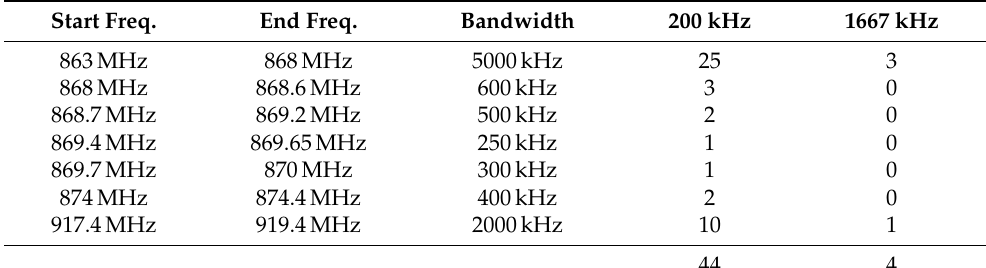
Table 2. Possible channel allocations for 200kHz and 1000kHz channels in the European sub-GHz frequency band, as listed by Van Leemput et al.